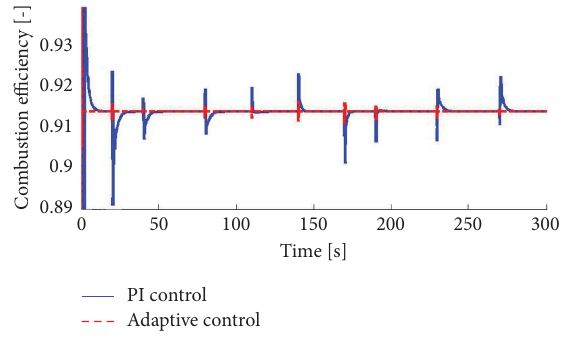
Figure 11: Combustion efciency.